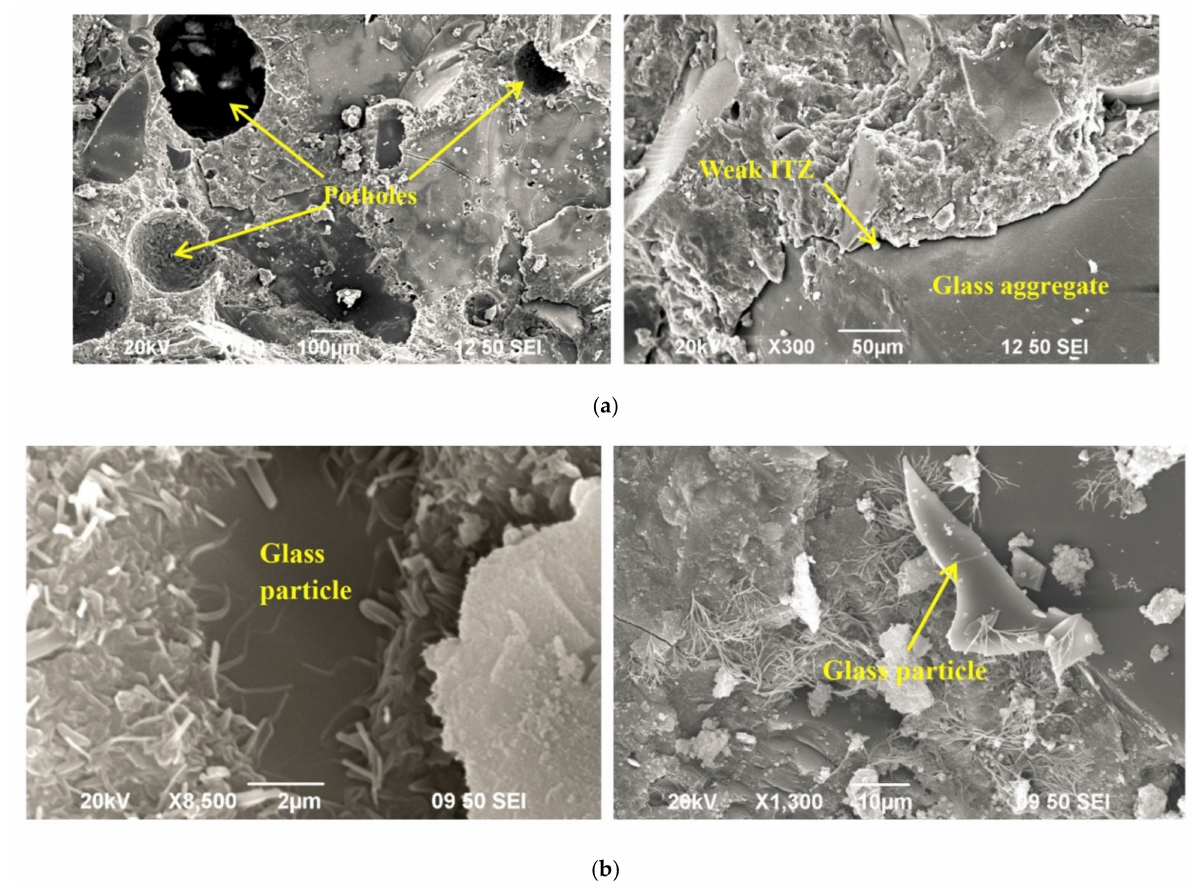
Figure 13. Microstructure and ITZ of mortar with WG aggregates [90]. ( a ) WG particle mean diameter of 204 µ m. ( b ) WG particle mean diameter 28.3 µ